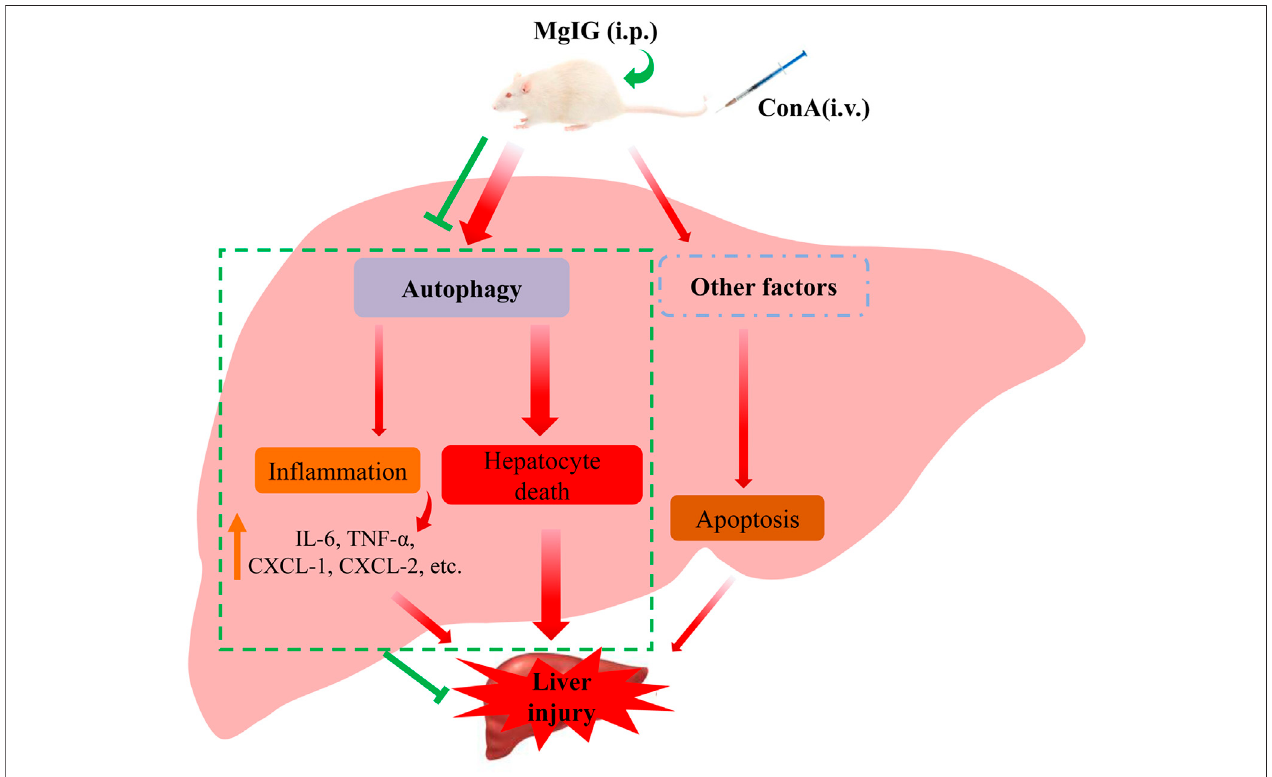
FIGURE6| ProposedmechanismunderlyingthepositiveeffectsofMgIGonConA-inducedliverinjuryinmice.MgIGinhibitsautophagy,therebyreducingthedirect damage caused by abnormal autophagic fl ux, which is the primary molecular mechanism. Furthermore, MgIG inhibits the expression of some in fl ammatory factors by inhibiting autophagy to attenuate the in fl ammatory response, thereby indirectly reducing liver damage.